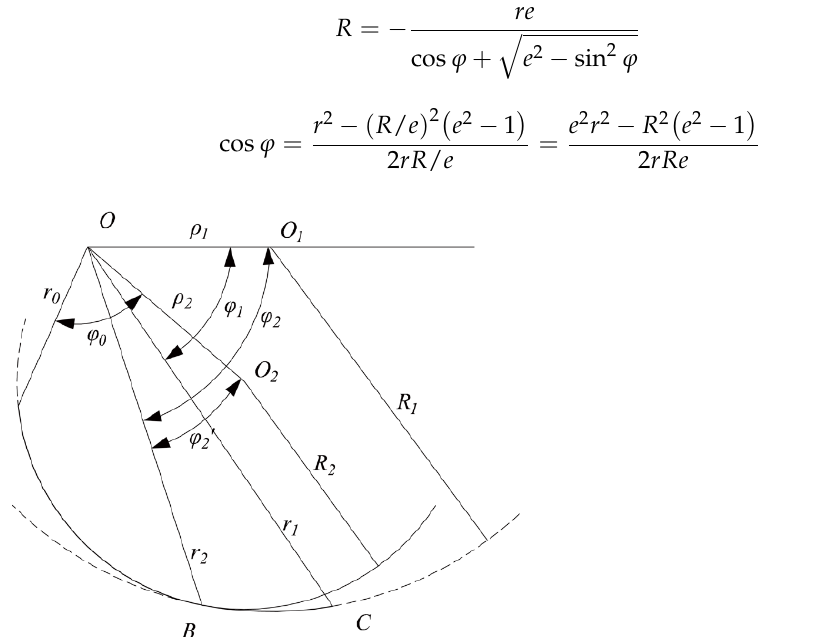
from plant entanglement, the minimum working radius r 0 was reduced to 125 mm within a reasonable range. The extreme diameter r 1 at the bending line was 230 mm, consistent with the tillage depth requirements of Cyperus esculentus harvesting. The coordinate system was established with the rotation center as the origin, and the double-eccentric circle curves AB and BC are shown in Figure 4. The eccentric circle radius R and the polar angle ϕ at any point on the eccentric circle curve were calculated by: